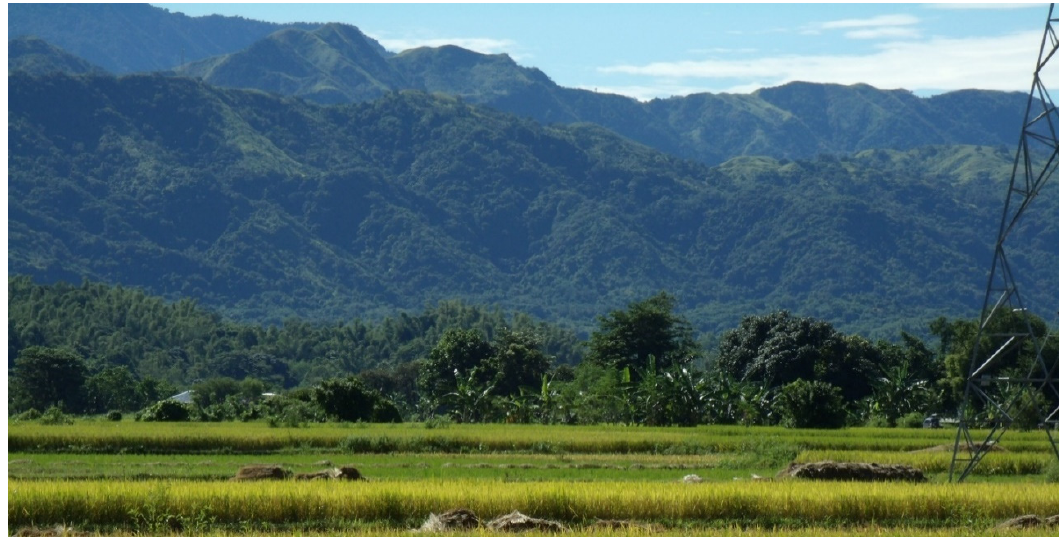
Figure 7. A series of left-laterally offset spurs mark the location of the Vigan-Aggao Fault’s active trace along the highly linear mountain front in the Badoc-Sinait area (Ilocos Sur). Location of the photo is indicated by a black square in Figure 6.